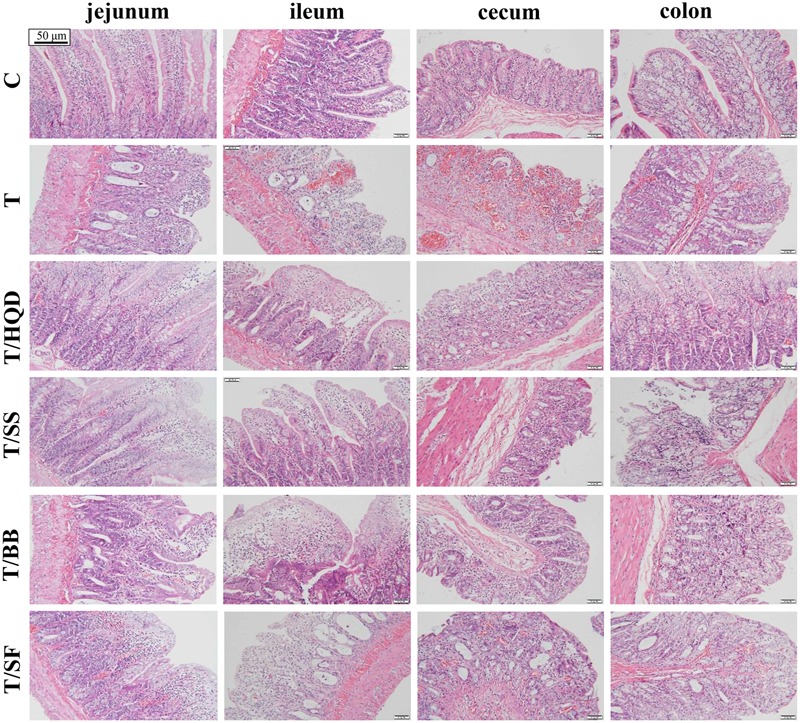
Effect of TCM (HQD, SS, BB, or SF decoctions) on CPT-11 induced intestinal damage in rats. Hematoxylin and eosin (H&E) staining was used to visualize the formalin-fixed sections of jejunum, ileum, cecum, and colon 3 days after treatment with CPT-11. SS, single S. baicalensis; BB, baicalin and baicalein; SF, S. baicalensis free; T, CPT-11.